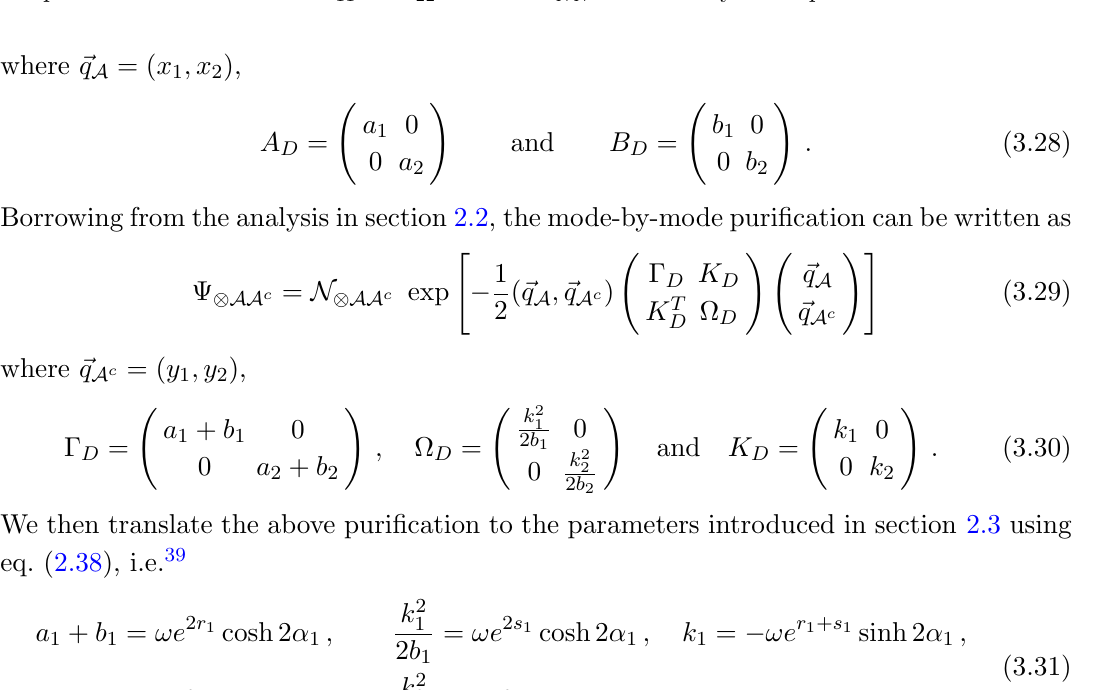
Figure 5 . Illustration of the di(cid:11)erent ways to purify a multi-mode Gaussian state ^ (cid:26) A . We refer to the puri(cid:12)cations of the form (cid:9) 11 c (cid:10) (cid:9) 22 c (cid:10) (cid:1) (cid:1) (cid:1) (cid:10) (cid:9) NN c as mode-by-mode